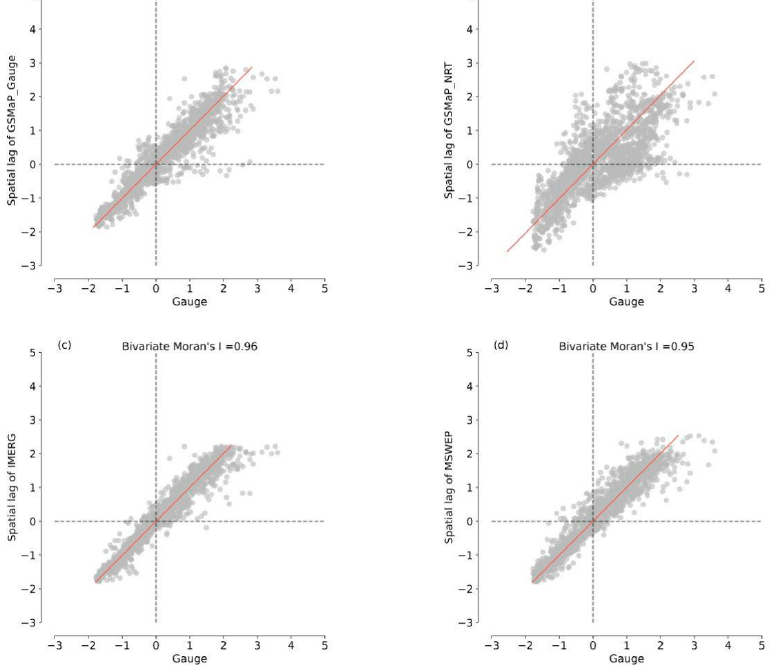
Figure 2. The global BMI sca tt er plot of ATP between the gauge observations and the four SPPs: ( a ) GSMaP_Gauge, ( b ) GSMaP_NRT, ( c ) I